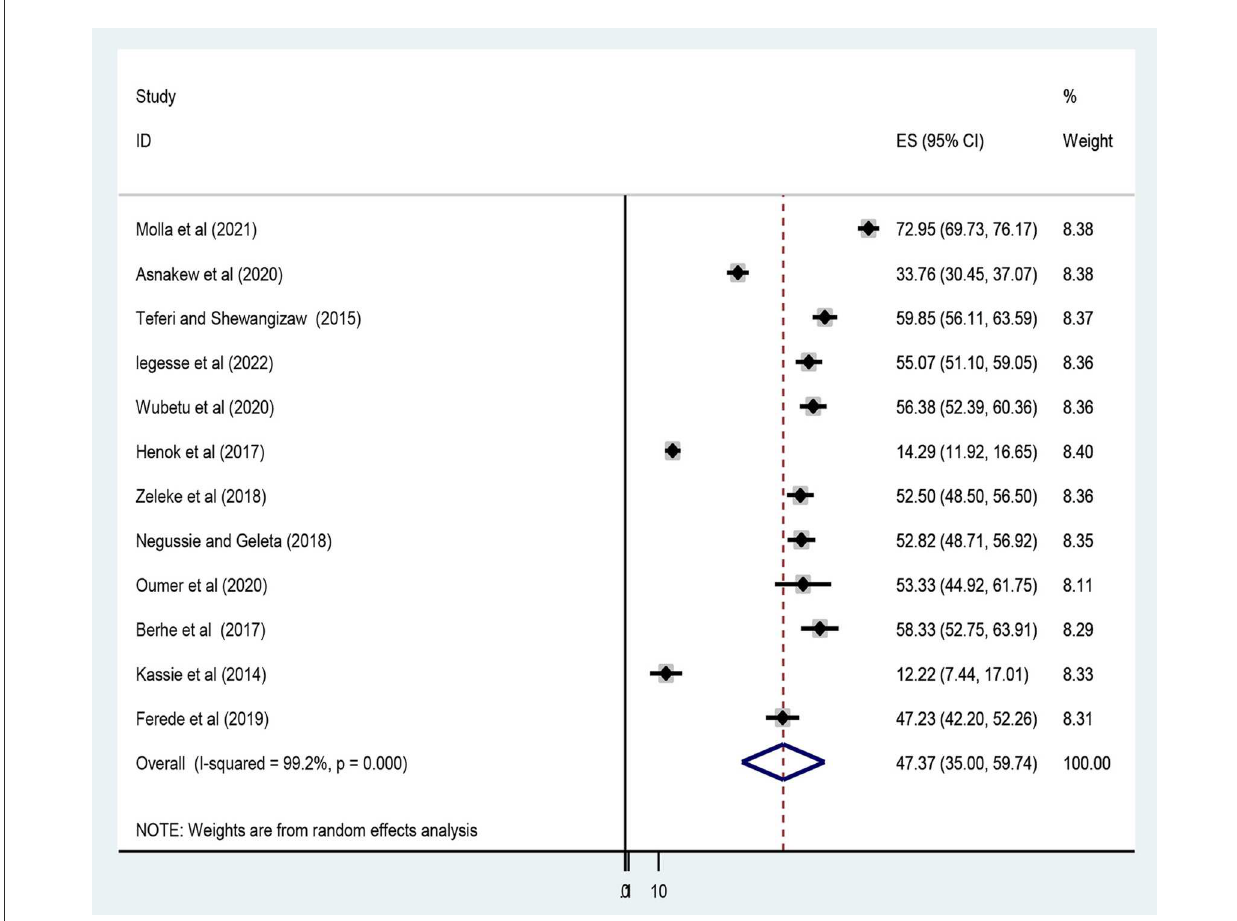
FIGURE3 Forest plot showing the pooled prevalence of a good epilepsy knowledge among